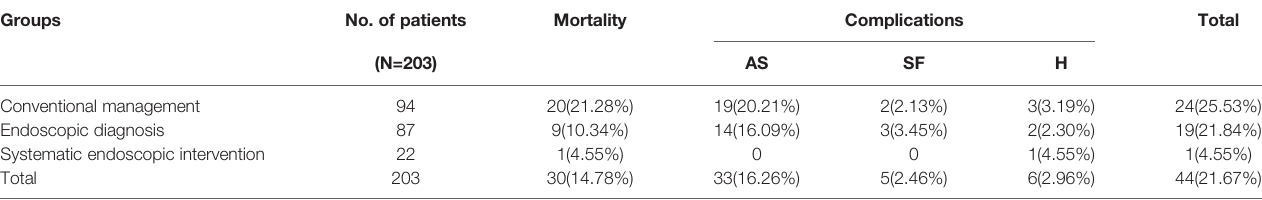
TABLE 5 | Mortality and Complications of the 203 patients with EAL.